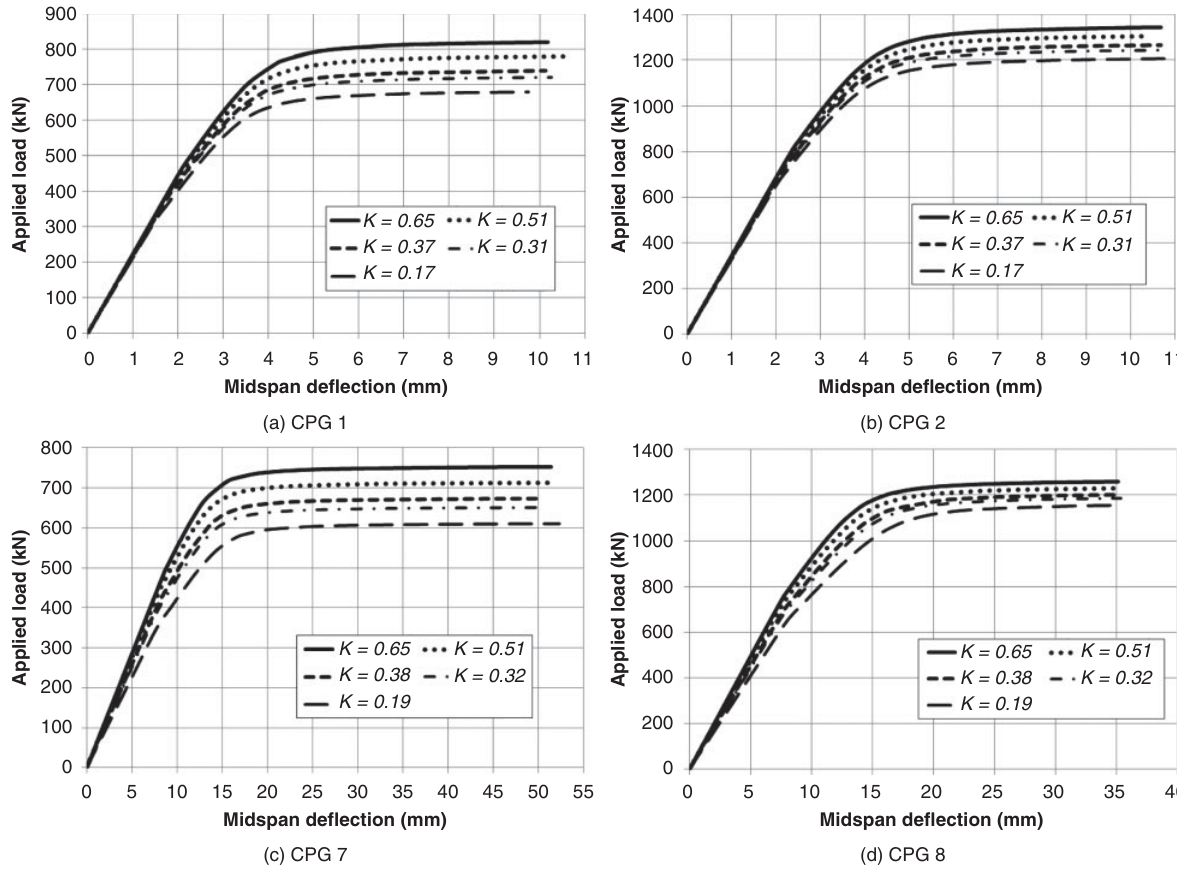
Fig. 7. Behaviour of girders under single concentrated load at mid-span: (a) CPG 1; (b) CPG 2; (c) CPG 7; (d) CPG